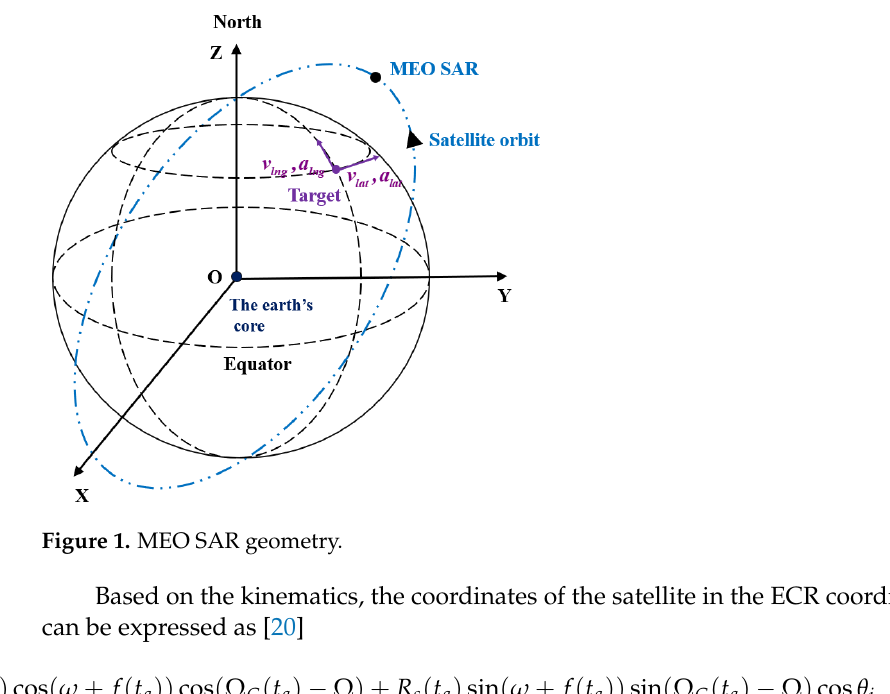
where ω means the argument of perigee, f ( t a ) represents the satellite’s true anomaly, a indicates the orbit’s semi-major axis, and e represents the eccentricity, Ω is the right as- cension of ascending node, θ i defines the orbit’s inclination, and Ω G ( t a ) = Ω G 0 + ω e t a pre- sents the Greenwich Hour Angle (GHA), where ω e refers to Earth’s rotational angular ve- locity, and Ω G 0 indicates the GHA at t a = 0. The detailed derivation of (1) can be found in [20].